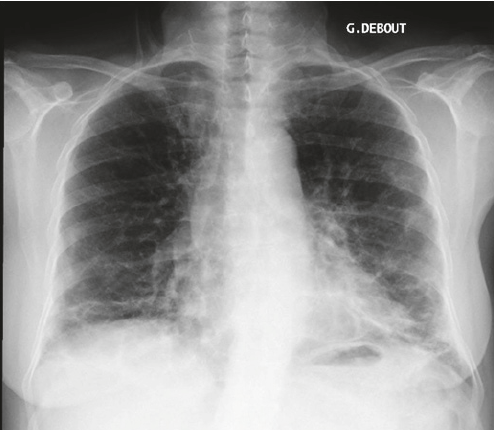
Figure 2: The chest X-ray (in standing position) showing the clear regression of alveolar condensation with some persistentsequelae at both pulmonary bases 1 month after ARDS.